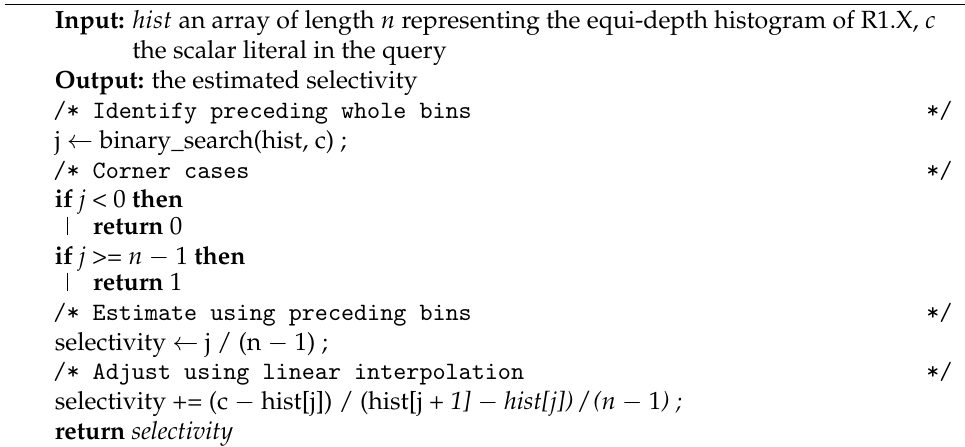
Algorithm 1: Restriction selectivity estimation for the expression R1.X < c.